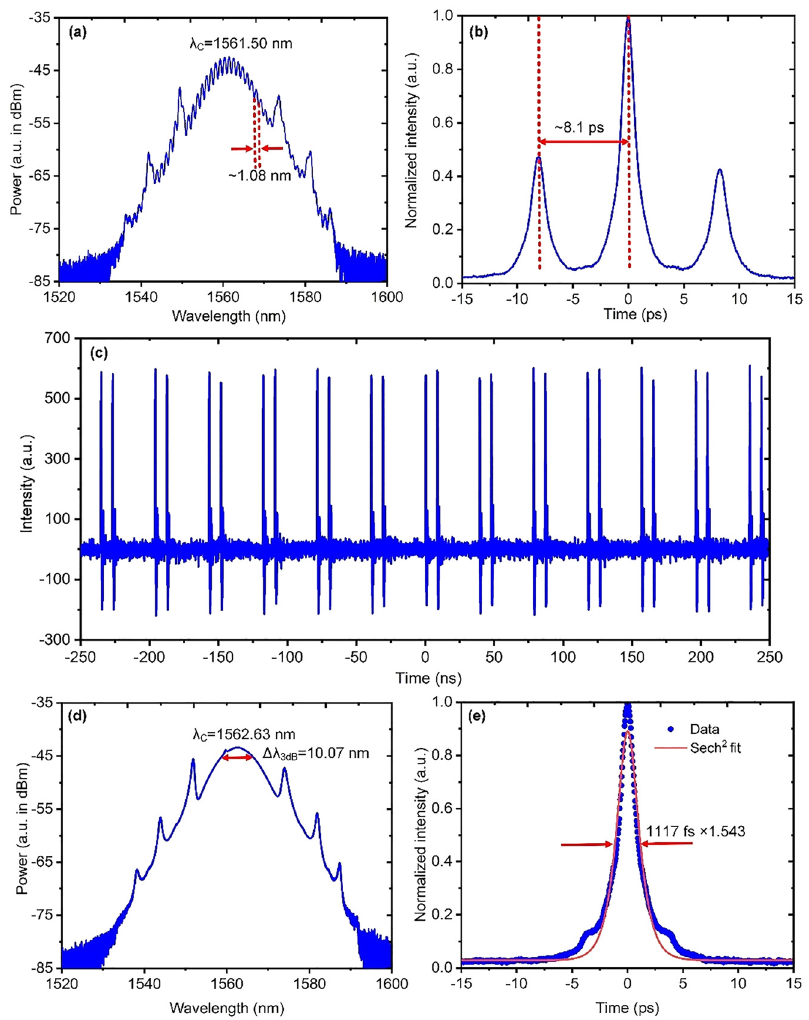
Figure 6: Bound-state and completely split solitons by using the same 30 mm long BPQDs-coated TF. Bound-state solitons: (a) output spectrum; (b) AC trace of the bound-state soliton. Completely split soli- tons: (c) a typical pulse train with